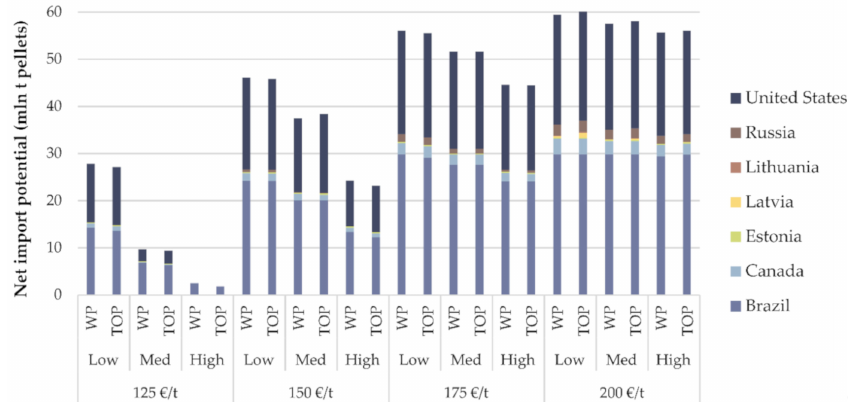
Figure 8. Techno-economic pellet production and net import potentials, CIF ARA, limited by supply chain costs–for wood pellets (WP) and torrefied pellets (TOP)–calculated using di ff erent assumptions on the development of pelletizing costs and shipping fuel and charter costs in a Low, Medium and High